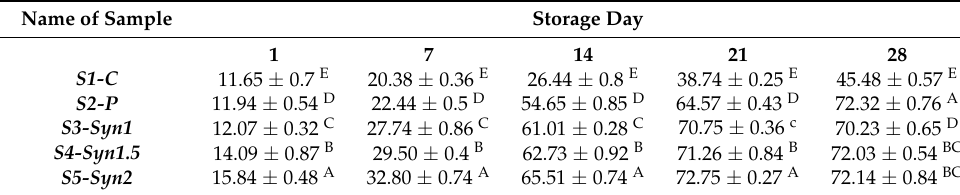
Table 2. Influence of storage time on the antioxidant activity of different yogurt samples. Name of